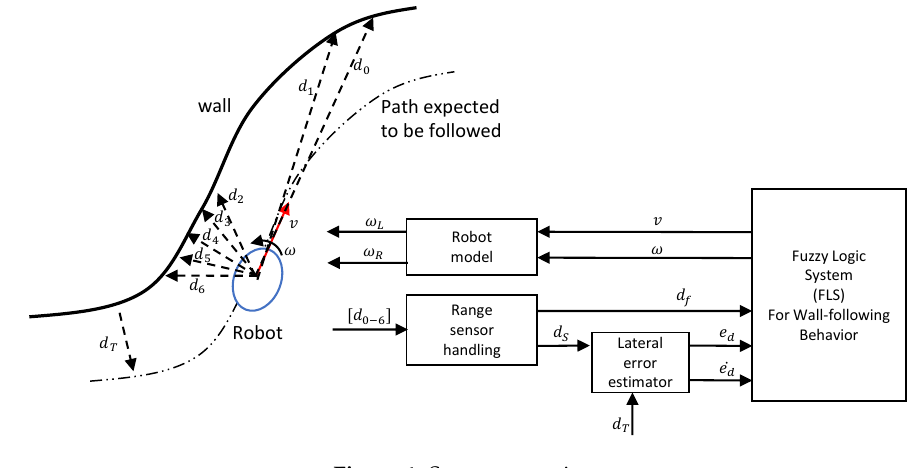
Figure 1. System